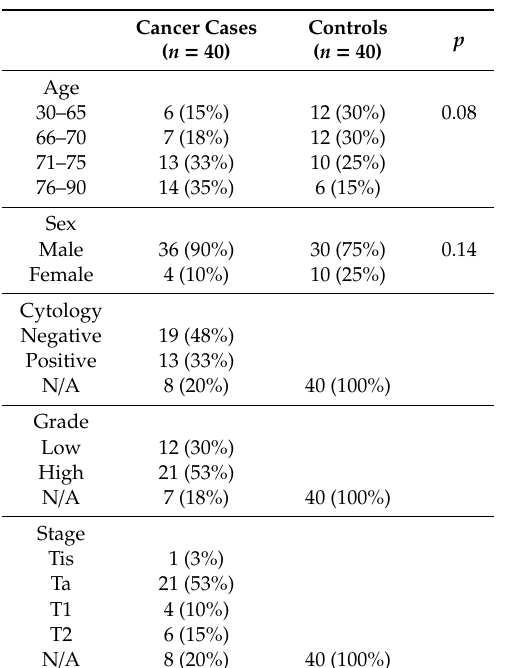
Table 2. Demographic and clinical-pathologic characteristics.